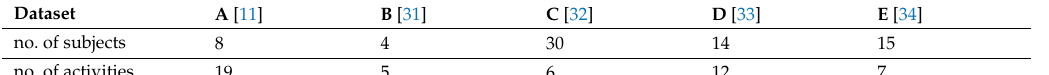
Table 1. Attributes of the five